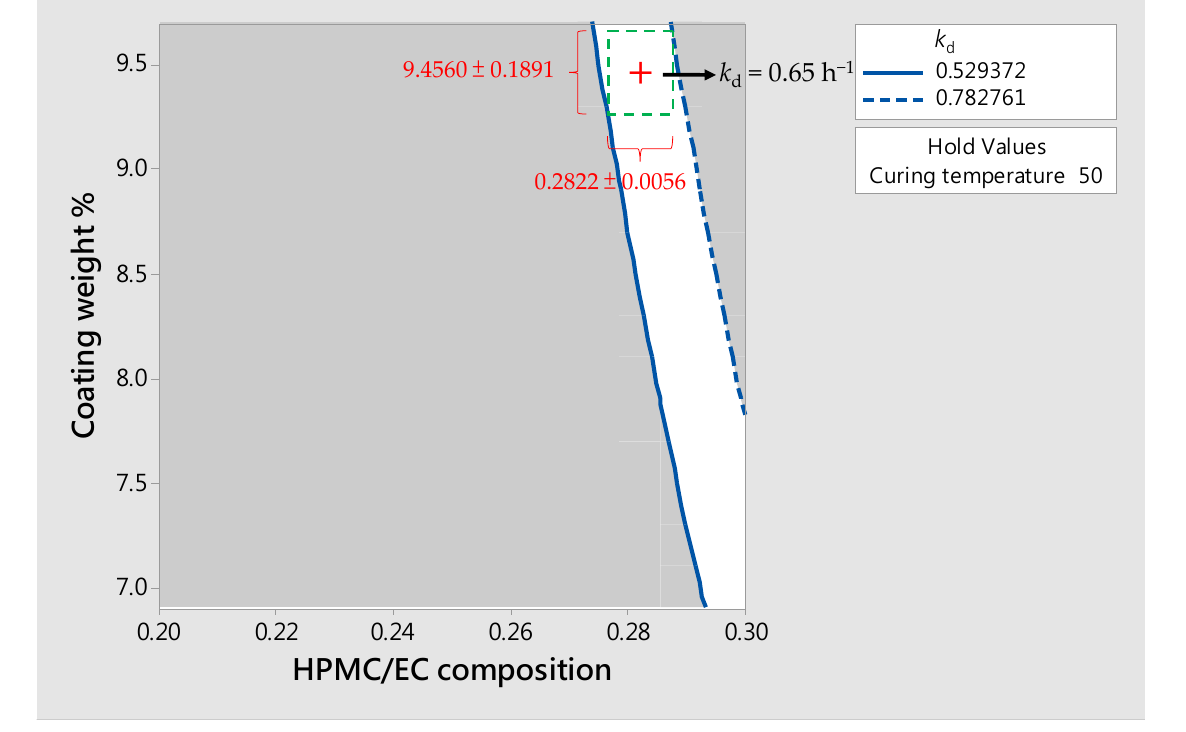
Figure 7. A contour plot of constants of dissolution ( k d ) predicted by the DoE. The boundary conditions to the target k d of SR pellets is shown by the green dotted-line area, that is, the acceptable specification of k d is 0.65 ± 0.13 h − 1 .